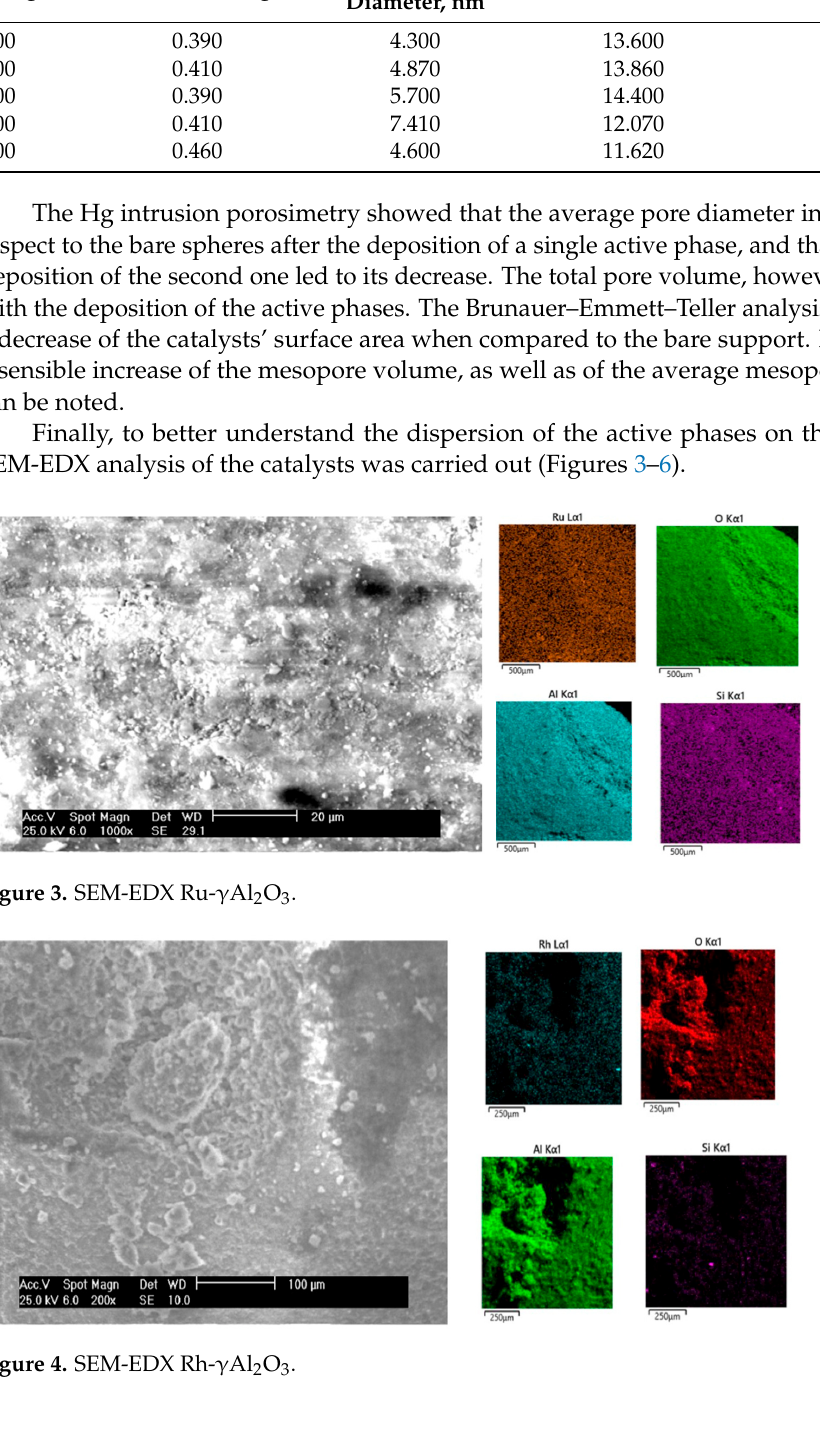
Figure 5. SEM-EDX Ru,Rh- γ Al 2 O 3. Figure 6. SEM-EDX Rh,Ru- γ Al 2 O 3. As can be clearly seen from Figures 3–6, for both the monometallic catalysts and the bimetallic ones, a homogeneous deposition of the active phases on the whole surface of the support was obtained.